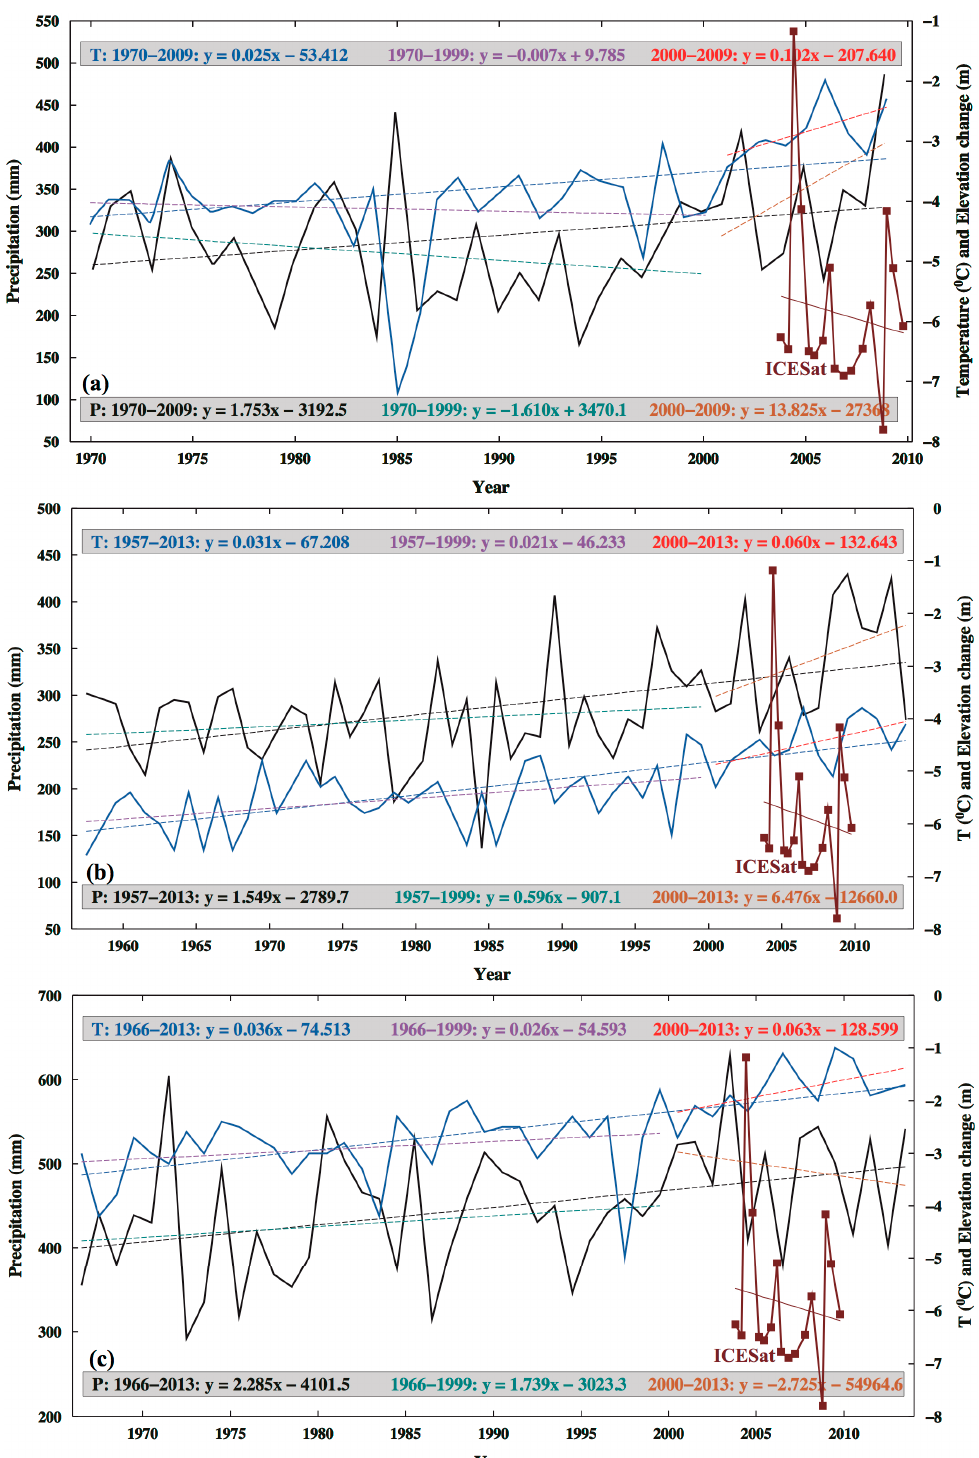
Figure 8. Mean annual temperatures (T, blue), annual precipitations (P, black)) at ( a ) Tuotuohe weather station; ( b ) Wudaoliang weather station; and ( c ) Anduo weather station, fitted by straight lines y = ax + b over different periods of time. ( x is time, y is T or P, a is the rate in °C/year or mm/year, and b is a constant). Overlapped in ( a – c ) are elevation changes from Figure 4, shifted by 4 m. The vertical labels on the right are for both temperature and shifted elevation change.